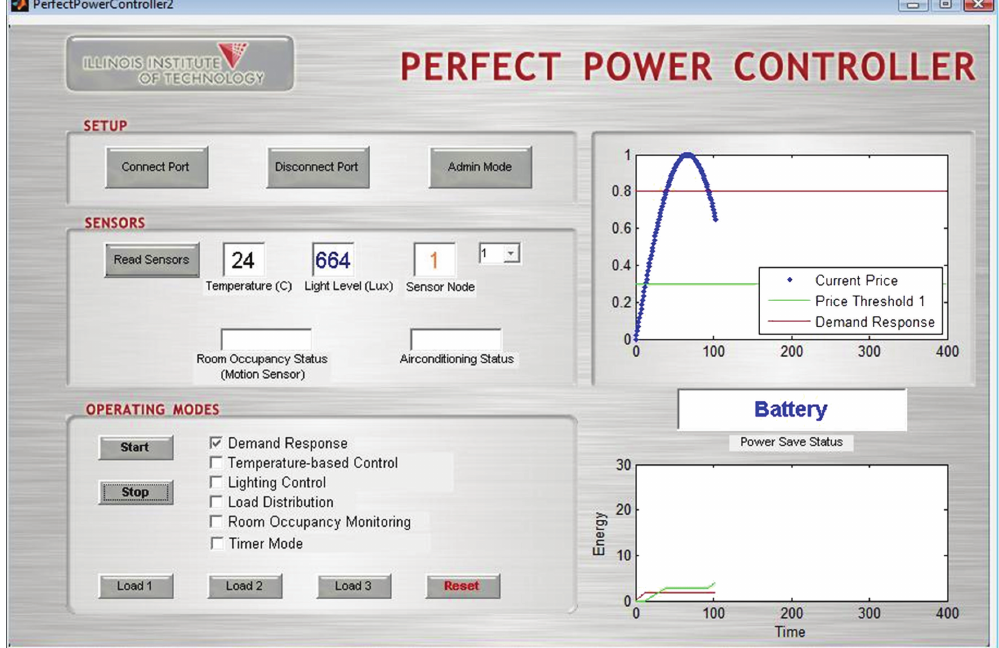
Figure 3: Perfect power controller